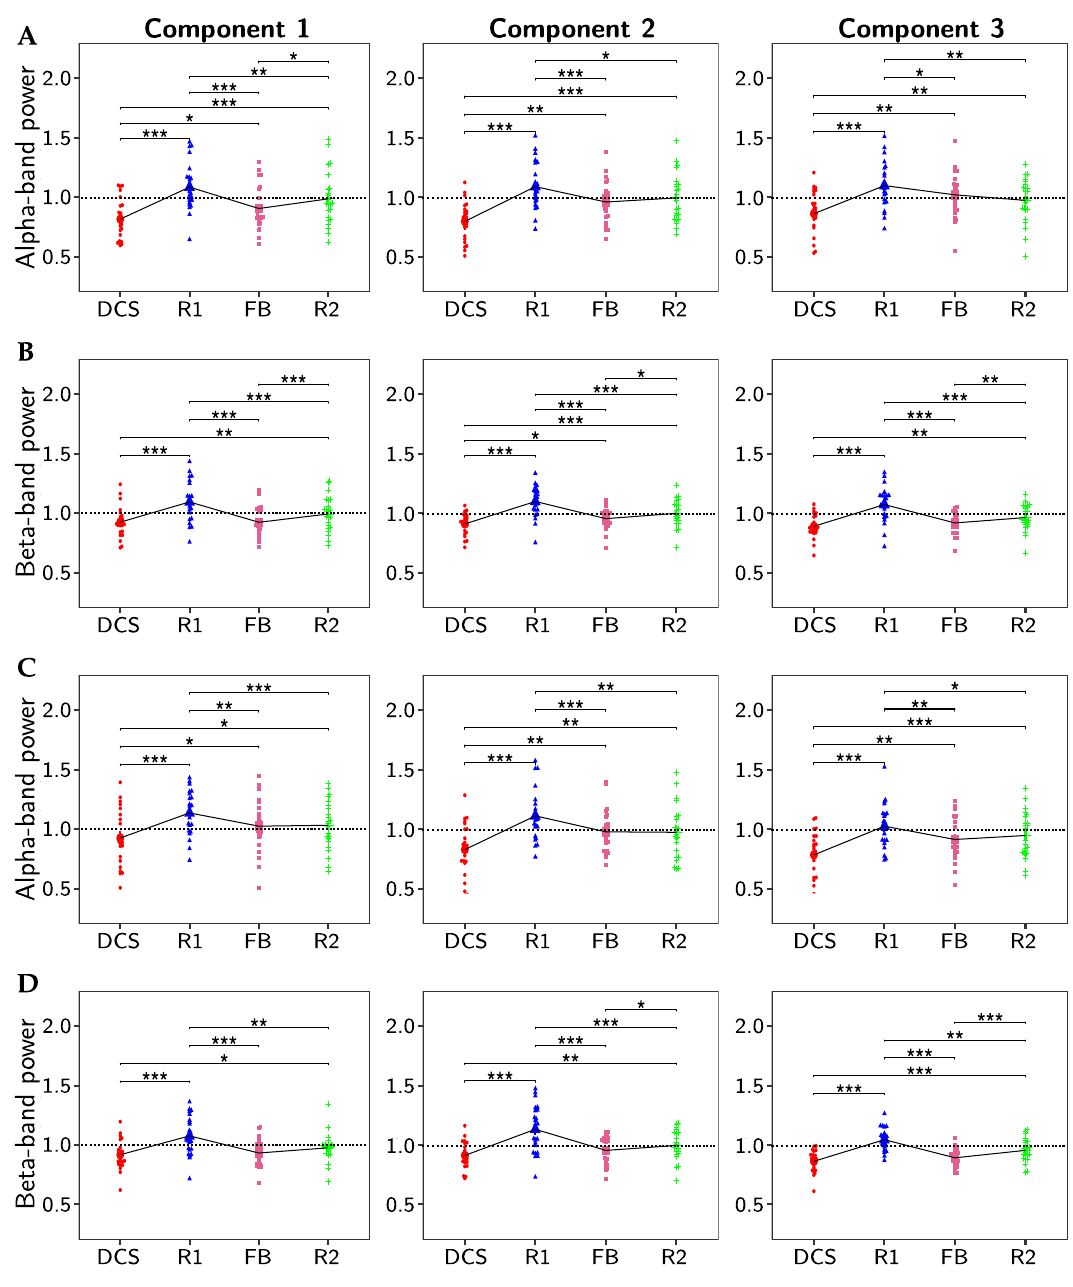
Figure 6. Normalized alpha- and beta-band power of the first three CorrCA projection components for ISC and ITC under four task periods (DCS, R1, FB, and R2) pooled from HM and LM. Specifically, ( A ) shows normalized alpha-band power of three ISC projection components; ( B ) normalized beta-band power of three ISC projection components; ( C ) normalized alpha-band power of three ITC projection components; ( D ) normalized beta-band power of three ITC projection components. Statistical results obtained by Tukey multiple comparison tests are mark as ‘***’ for p Tukey < 0.001 , ‘**’ for p Tukey < 0.01 , and ‘*’ for p Tukey < 0.05